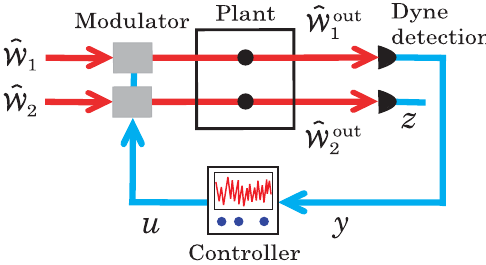
FIG. 6. General configuration of the type-2 MF